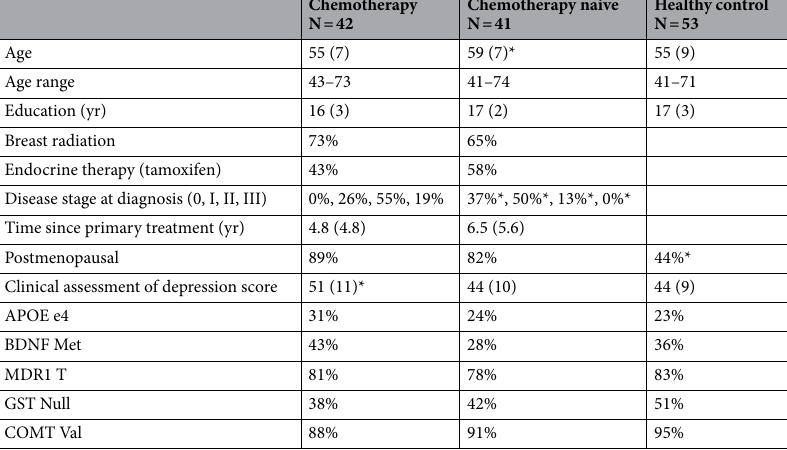
Table 1. Demographic, genotype and clinical data show as mean (standard deviation) unless otherwise noted. *Denotes significant ( p < 0.05)